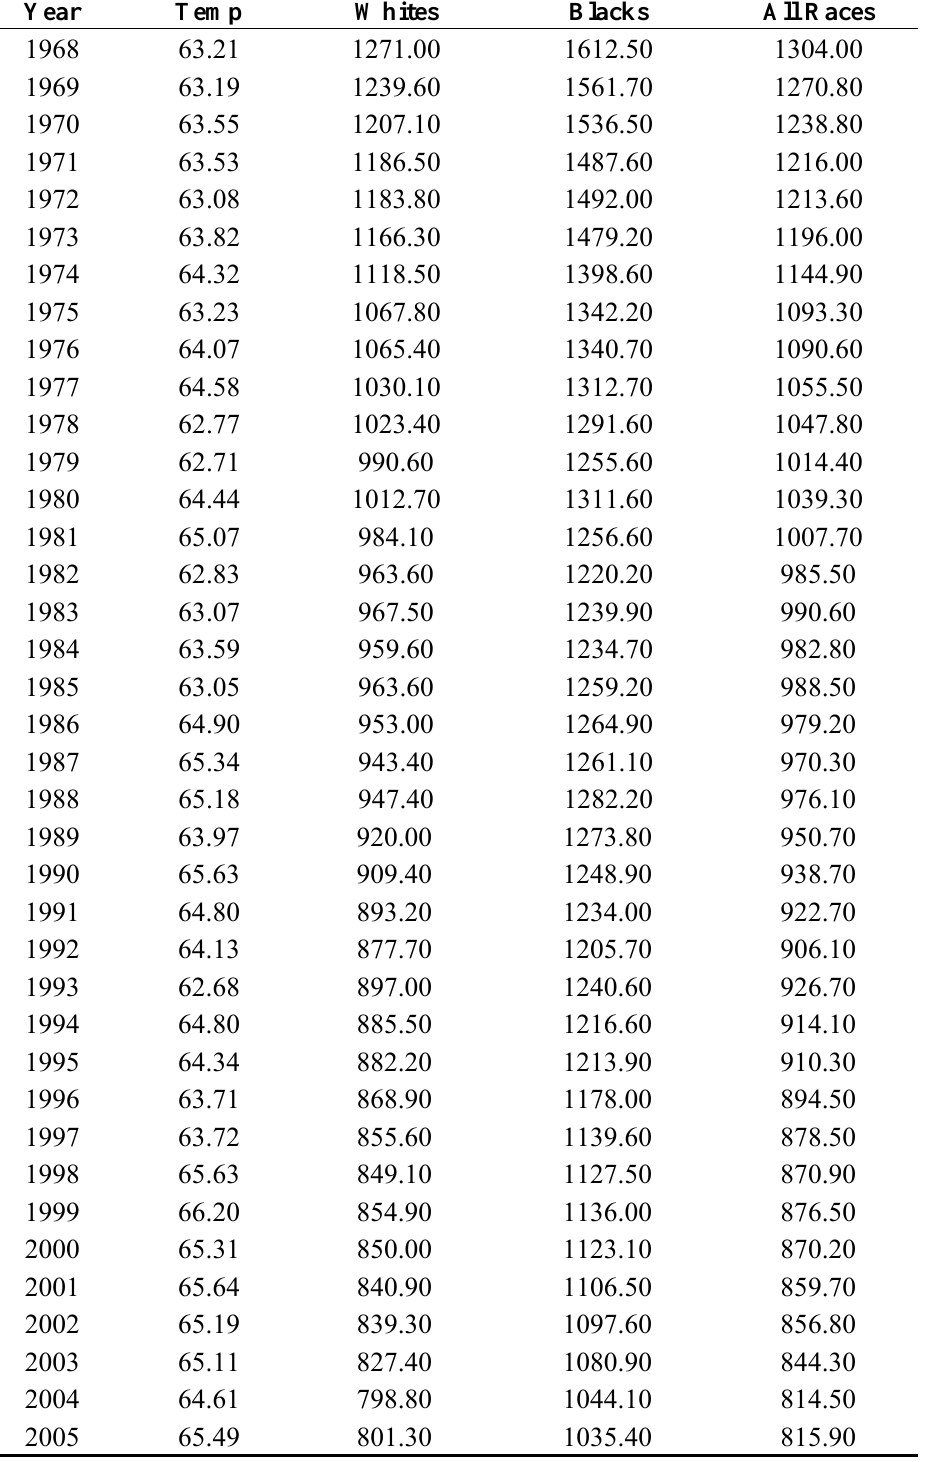
Table 2. Raw averages for the four variables in the study. Temp = average daily maximum air temperature [8]. Whites, blacks, and all races refer to race categories for the age-adjusted death